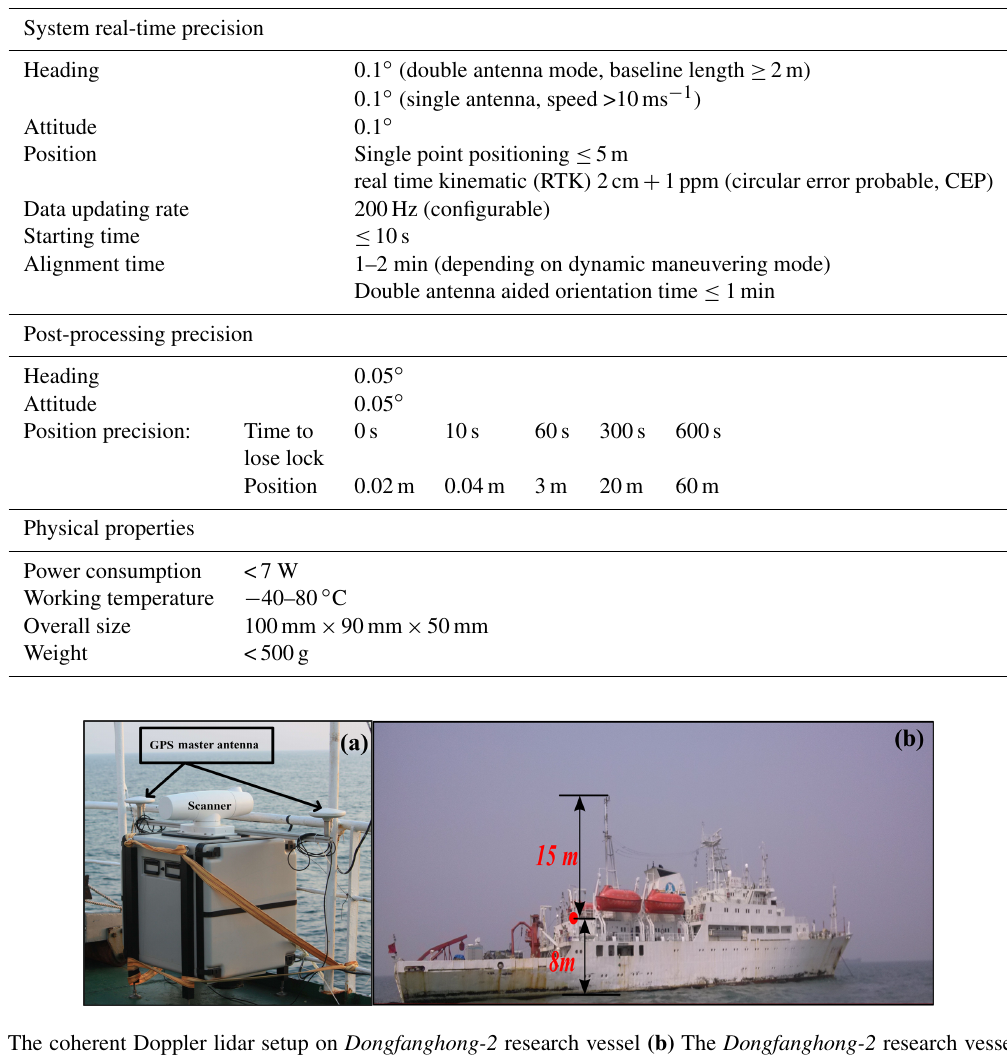
Figure 1. (a) The coherent Doppler lidar setup on Dongfanghong-2 research vessel (b) The Dongfanghong-2 research vessel during 2014 Yellow Sea Campaign. The red solid dot represents the CDL